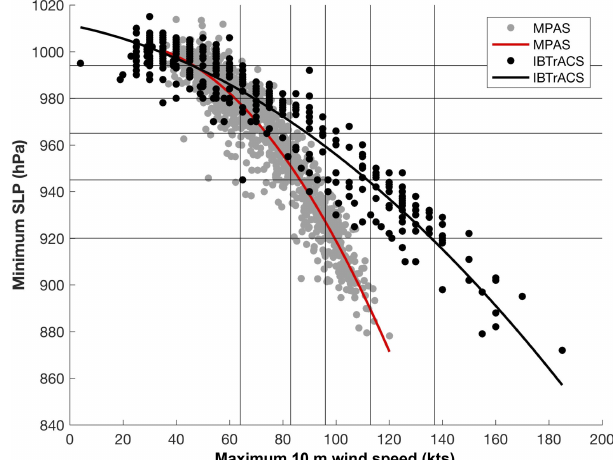
Figure 7. Scatter plot of maximum 10m wind speed (kts) versus minimum SLP (hPa) for IBTrACS (black) and present-day MPAS- A (grey) Northern Hemisphere TCs. The lines of best fit for each (IBTrACS in black and MPAS-A in red) were computed using a second-order polynomial. The wind (SLP) category thresholds are indicated by the vertical (horizontal)